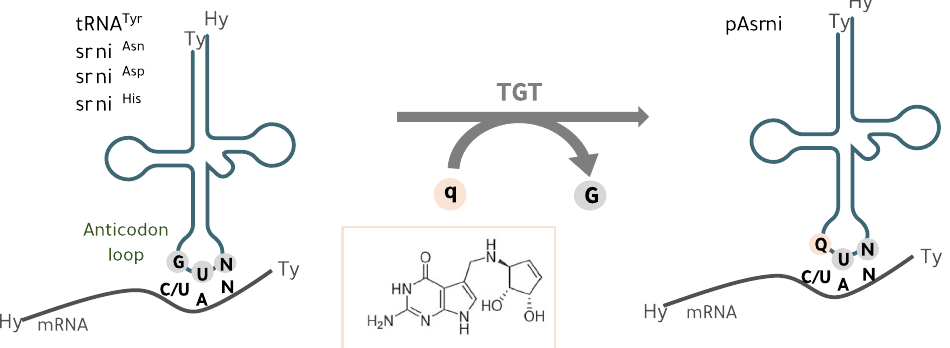
Fig 1. Queuine integration into tRNAs. In eukaryotic cells, the tRNA guanine transglycosylase (TGT) enzyme exchanges guanine (G) with the nucleobase queuine (q) at the wobble position (position 34, first base of the anticodon) of tRNAs that contain a GUN anticodon sequence (N = any base) and are specific to tRNA isoacceptors for tyrosine (tRNA Tyr ), asparagine (tRNA Asn ), aspartic acid (tRNA Asp ) and histidine (tRNA His ). Queuosine (Q) is the corresponding nucleoside of q and Q-tRNA base-pairing with NAY codons (Y = C or U) impacts speed and fidelity of mRNA translation [14,